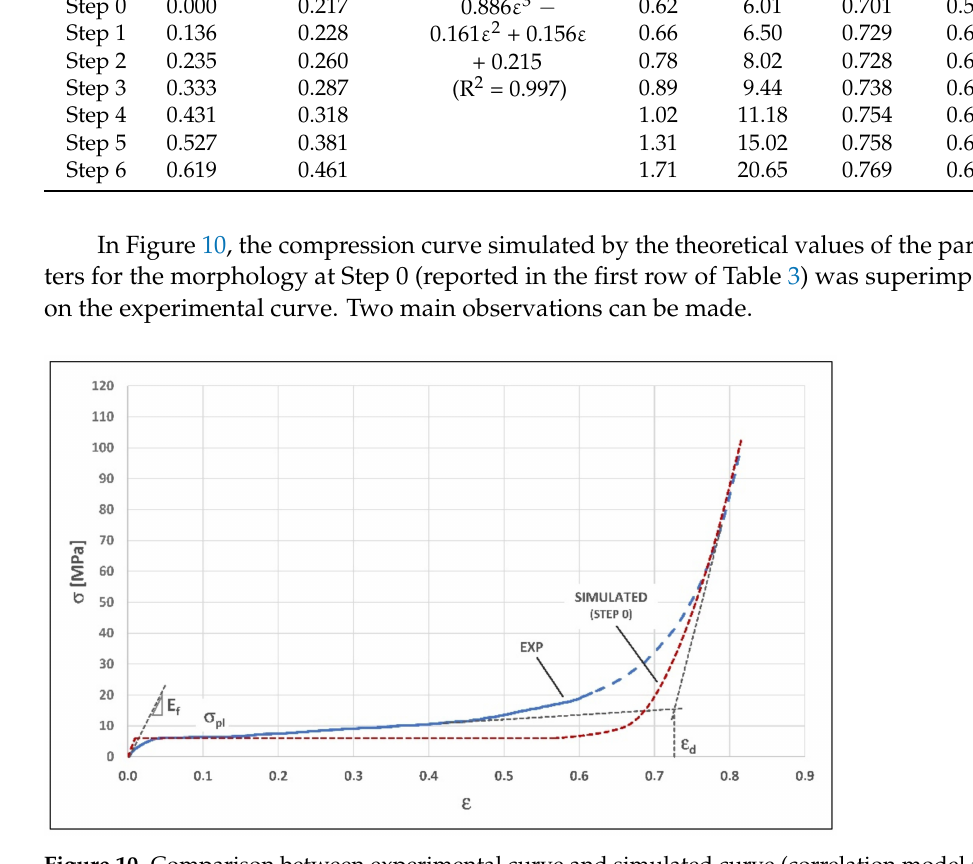
Figure 10. Comparison between experimental curve and simulated curve (correlation model fitted only on Step 0 morphology, 0.4% TiH 2